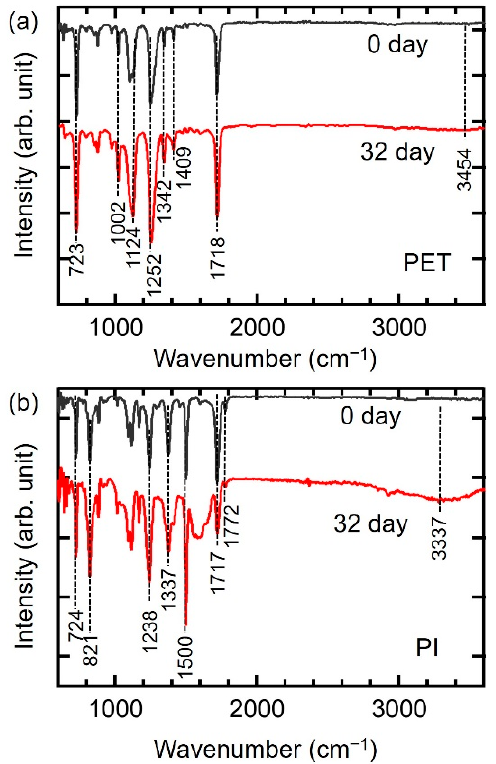
Figure 3. ATR-FTIR spectra of ( a ) raw PET and ( b ) raw PI films with their corresponding aging films. Table 1. Influence of aging time on the ATR-FTIR group content of PET and PI